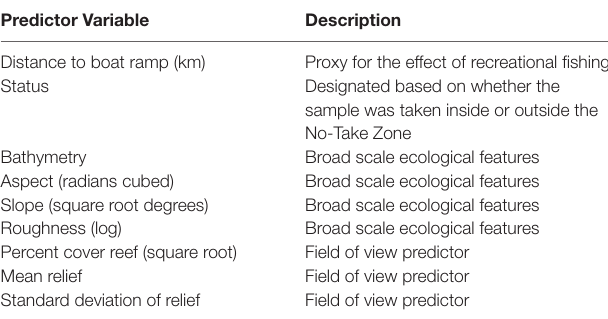
TABLE 1 | Predictor variables for fish assemblage metrics used in the model selection process. Predictor